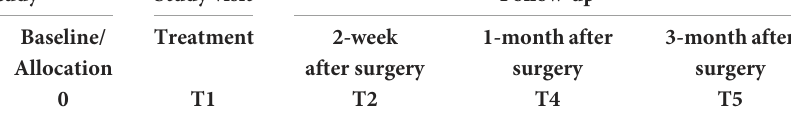
Pre-study Study visit Follow-up Enrollment Baseline/ Treatment 2-week 1-month after 3-month after Allocation after surgery surgery surgery -T1